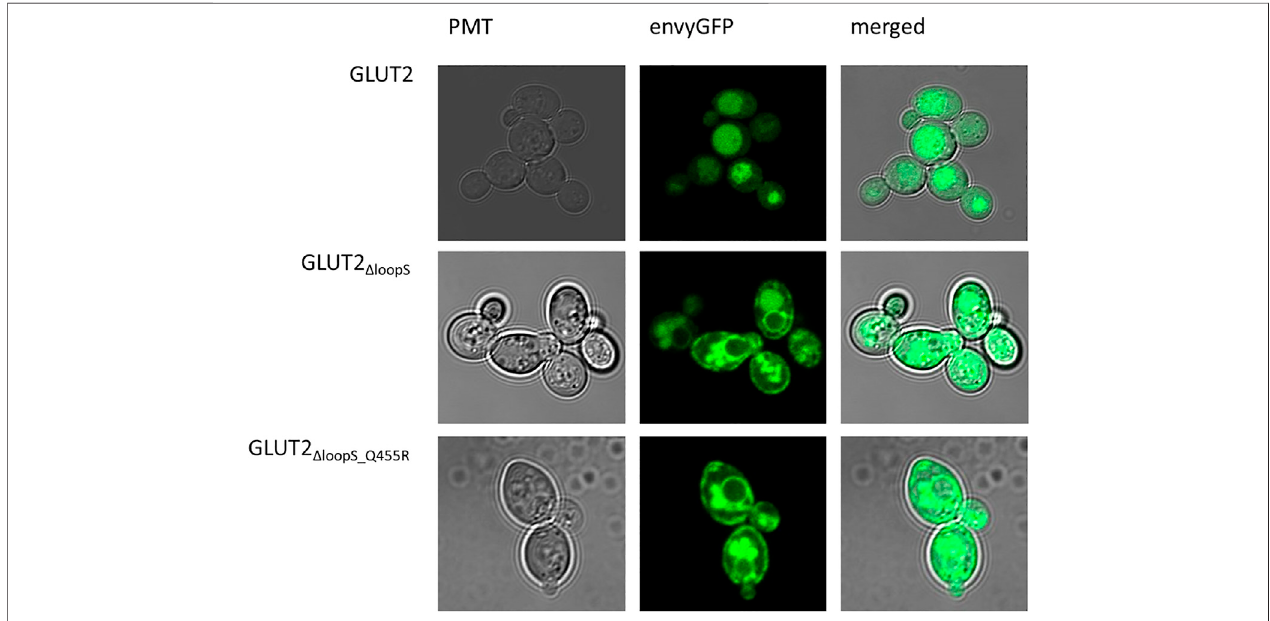
FIGURE4| SubcellularlocalizationofGLUT2variants.envyGFPwasfusedtotheC-terminiofGLUT2(wild-type),GLUT2 Δ loopS ,andGLUT2 Δ loopS_Q455R .CEN.PK2- 1C cells, expressing the respective envyGFP construct, were grown in low fl uorescent SC -URA medium containing 0.2% (w/v) glucose. For immobilization, 0.6% (w/v) low melt agarose was added to the suspension. Localization was analyzed with the Confocal Laser Scanning Microscope (Zeiss LSM 780, Jena, Germany).